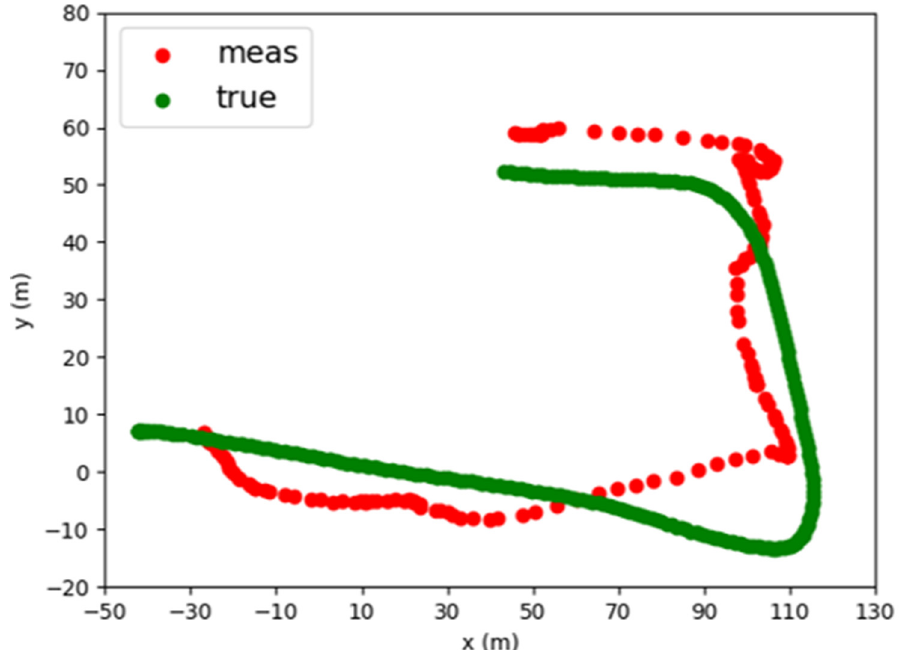
Figure 17. The ( a ) 𝐶𝑜𝑣(cid:4666)𝑠 (cid:3051) , 𝑠 (cid:3051) (cid:4667) and ( b ) 𝐶𝑜𝑣(cid:3435)𝑠 (cid:3052) ,𝑠 (cid:3052) (cid:3439) in the 𝑄 (cid:2870) matrix.